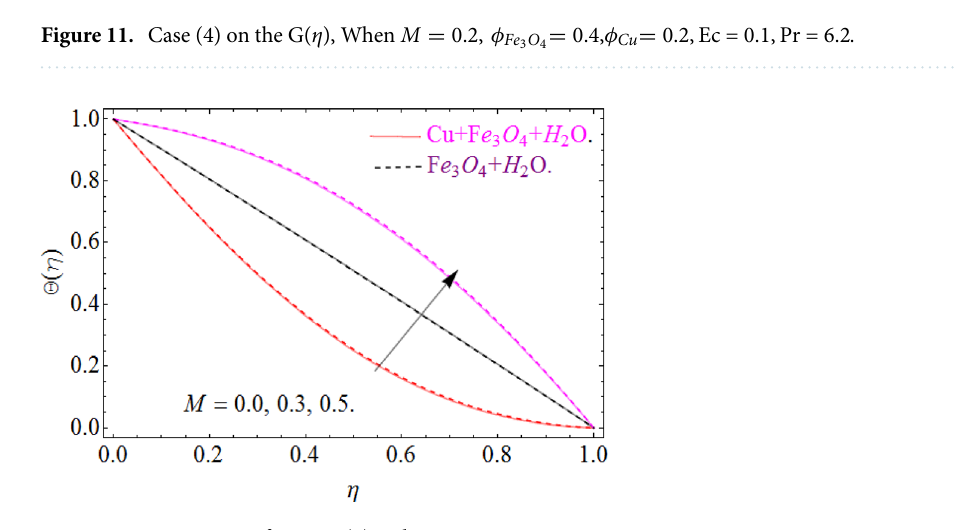
Figure 12. Impression of M on Θ( η ), When φ Fe 3 O 4 = 0.4, φ Cu = 0.2, Pr = 6.2, Re ω = 0.3, Re � = 0.13